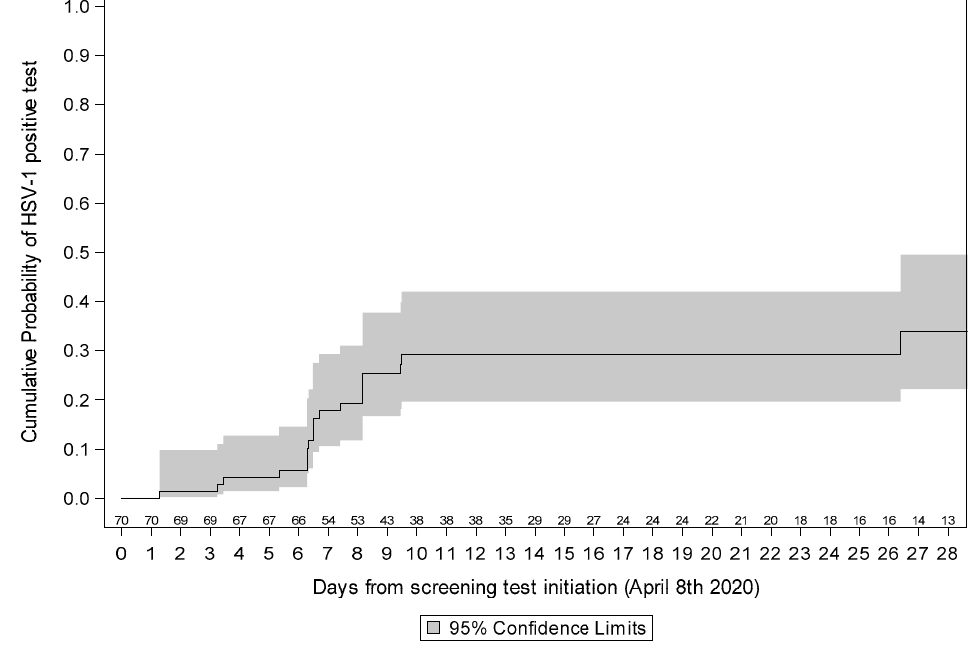
Figure 1. Kaplan–Meier estimates of HSV re-activation.